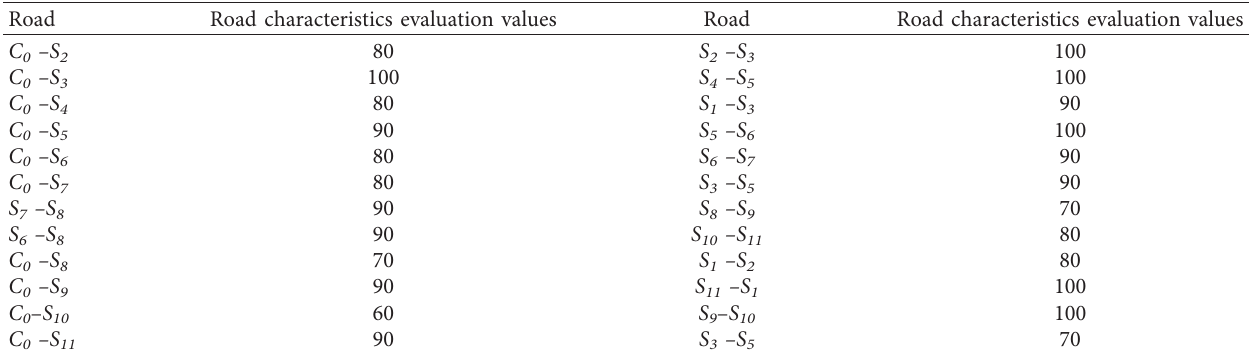
Table 4: Road characteristics evaluation values.